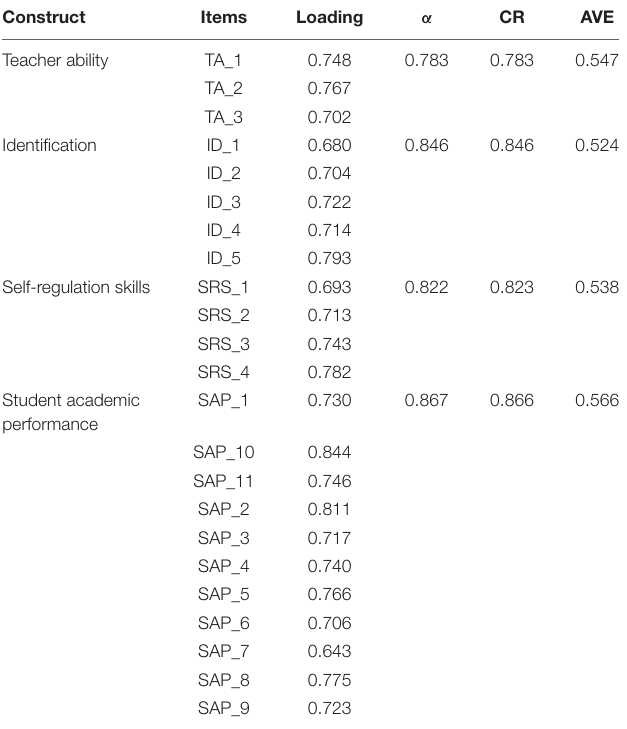
TABLE 2 | Reliability and validity